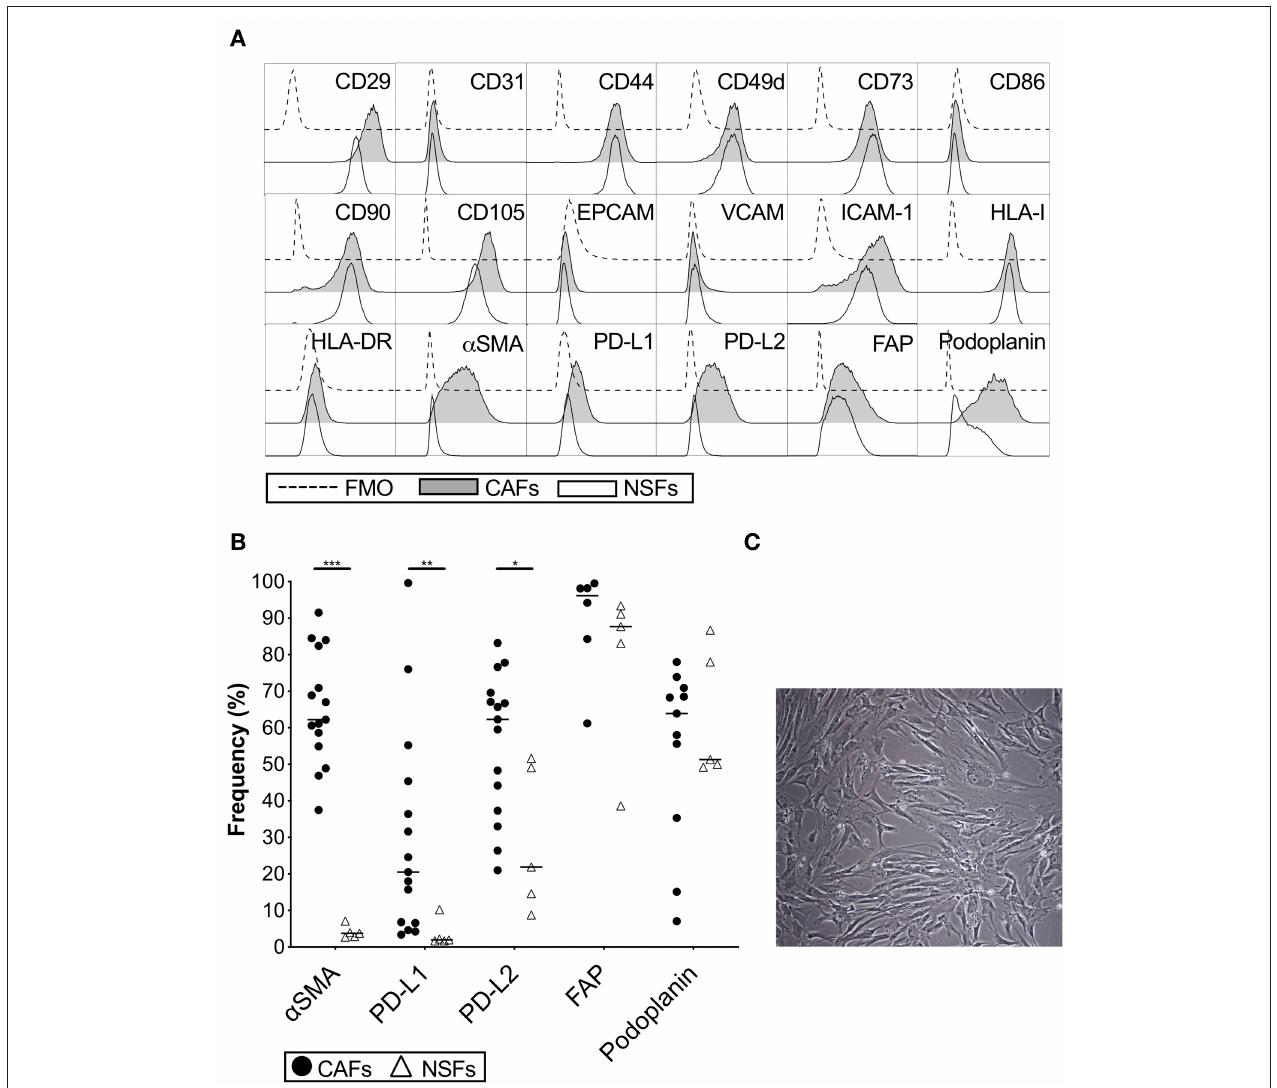
FIGURE 1 | Phenotypic analysis of carcinoma associated pancreatic stellate cells (CAFs) and normal skin fibroblasts (NSFs) by flow cytometry. (A) Representative histograms showing different CAFs (gray) and NSFs (white) molecules expression compared to FMO controls (dashed line). (B) Comparison of α -SMA, PD-L1, PD-L2, FAP and podoplanin expression between CAFs (black dots) ( n = 8–15) and NSFs (open triangles) ( n = 5). (C) Representative image showing the morphology of CAFs at passage 3 (Original magnification × 10). All fibroblasts were characterized in passage 3. The bars indicate the median. Wilcoxon matched-pairs signed rank test was used to detect statistically significant differences * P < 0.05, ** P < 0.01, *** P <